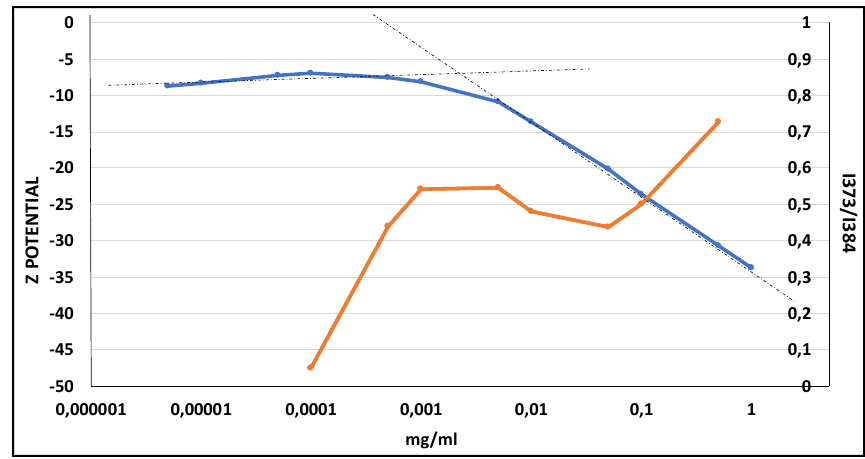
Figure 10. I 373 / I 384 intensity ratio obtained from pyrene emission spectra in the presence of poly-6-MOEG-9-T- BF3k -FE (blue curve) and Z-potential values (orange curve) as a function of polymer concentration.